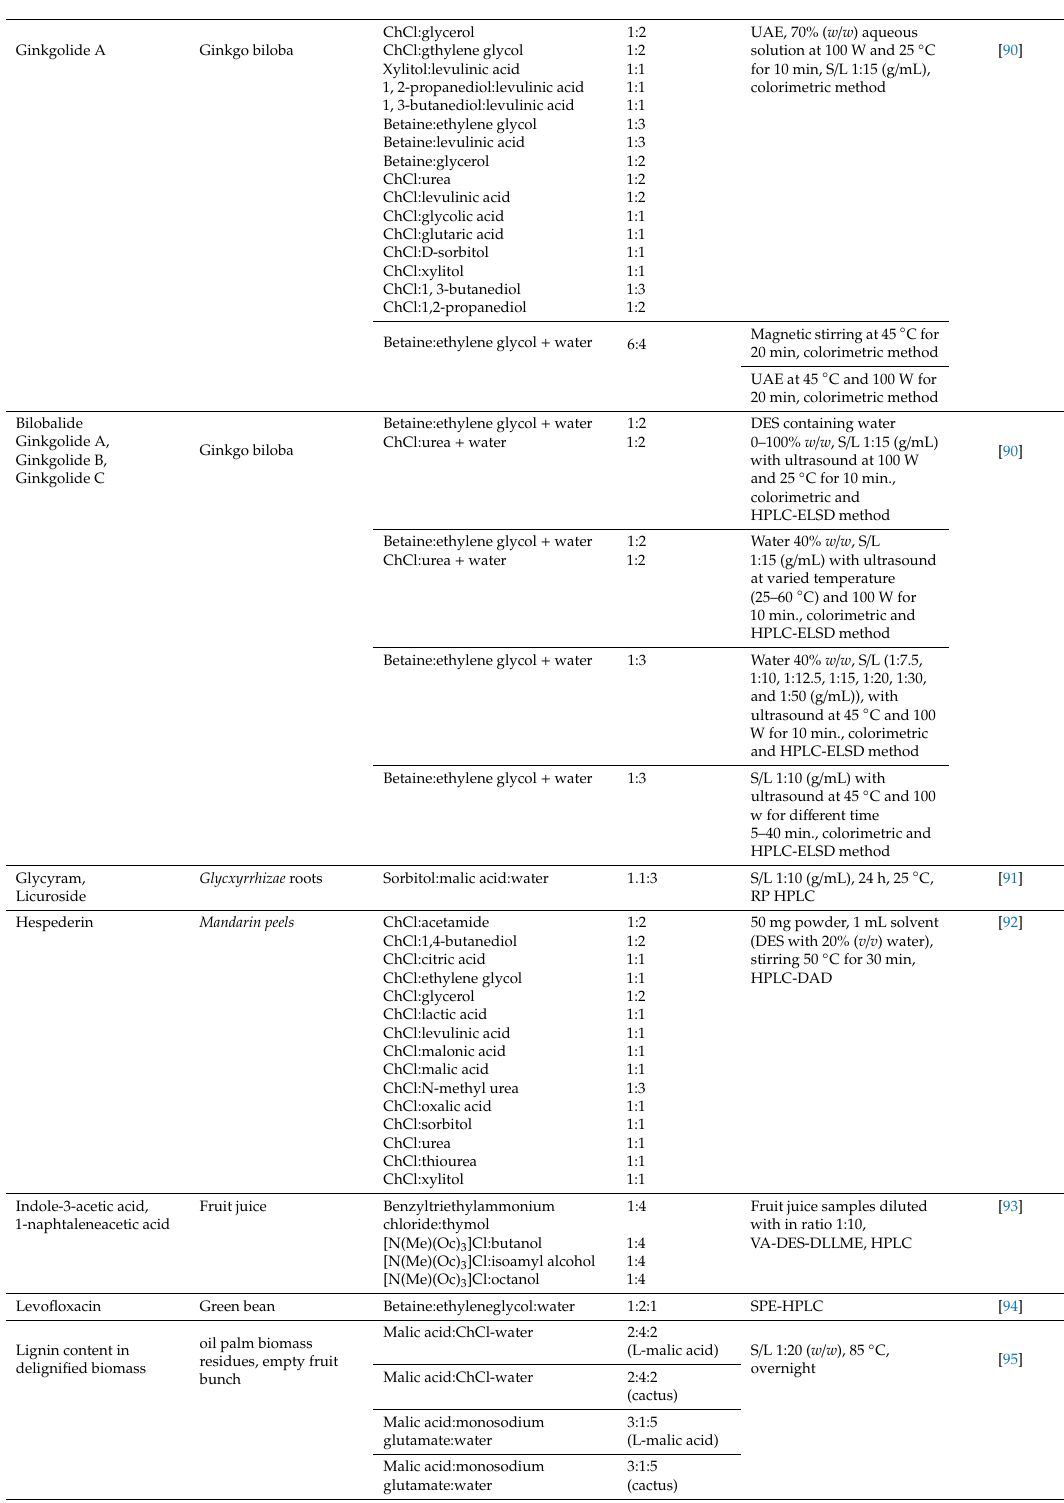
Magneticstirringat45 ◦ Cfor 20 min, colorimetric